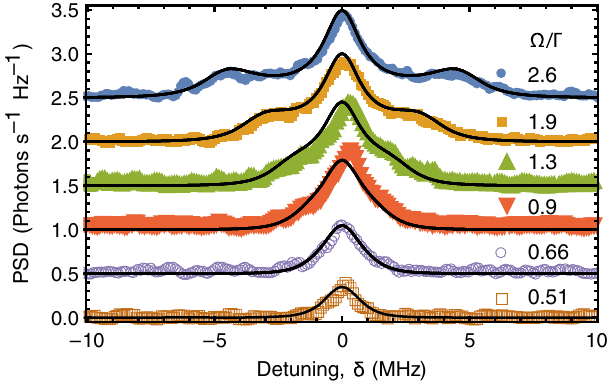
FIG. 7. Measured power spectral density (PSD) of the inelastic scattering of a coherent tone resonant with the source qubit (symbols) for various drive rates Ω in units of the linewidth Γ . Solid lines are fits to the data. Individual data sets are offset by 0 . 5 photons s − 1 Hz − 1 for clarity.